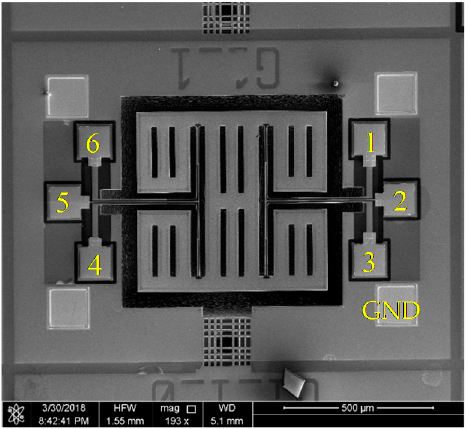
Figure 9. Scanning electron microscope (SEM) view of the AlN MEMS gyroscope.